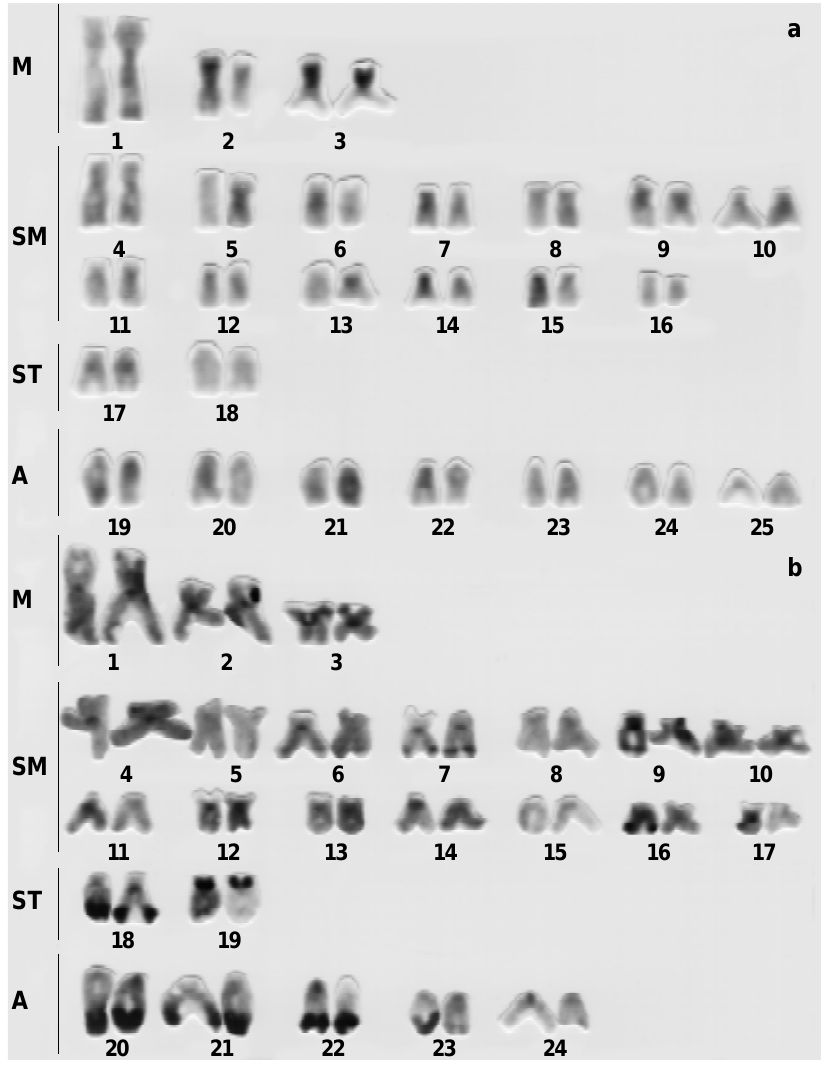
Figure 2 - C-banding karyotypes of A. scabripinnis from the Tamanduá stream. a , Cytotype I (2n = 50), and b , cytotype II (2n =